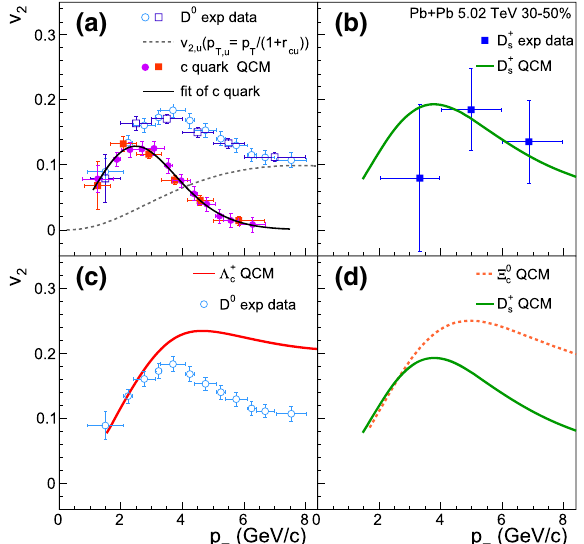
Fig. 5 a Charmquark v 2 extractedfrom D 0 mesoninPb+Pbcollisions √ s NN = 5.02 TeV for 30–50% centrality, and b – d the predictions at for D + s , Λ + c and Ξ 0 c . Data of D 0 and D + s are taken from Refs. [36–38]